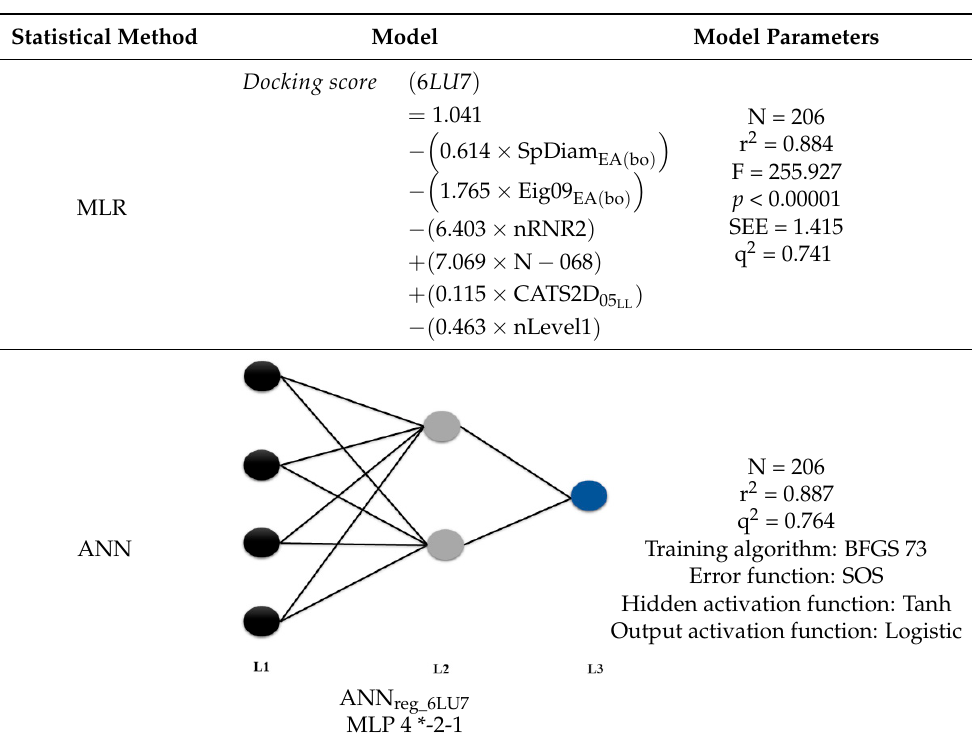
Table 4. Topo-chemical descriptors used in the construction of SARS-CoV-2